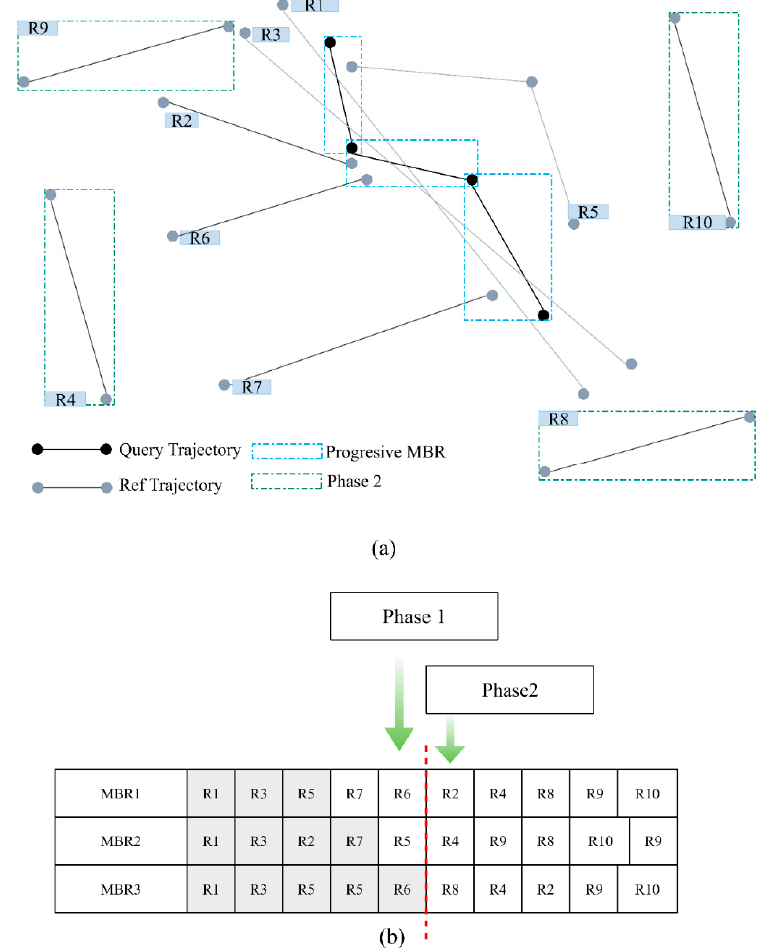
Figure 4. An example of selecting trajectories for Phase 1 and Phase 2 checking. ( a ) Spatial locations of trajectories; ( b ) sorted arrays for checking. Grey cells represent MINDIST = 0. For Phase 1, the unique trajectories are R1, R2, R3, R5, R6 and R7 (any trajectories with MINDIST = 0). For Phase 2, R2 is